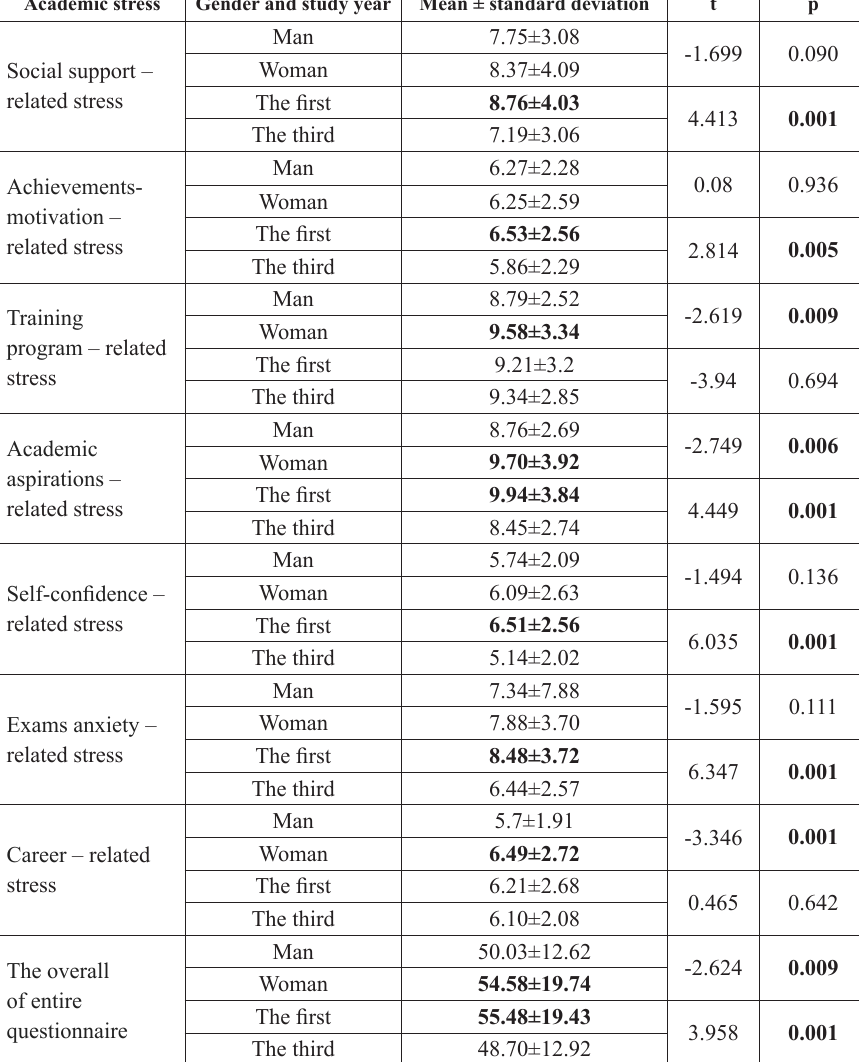
Table 2. Comparison of acade- mic stress between gender and the first and third-year